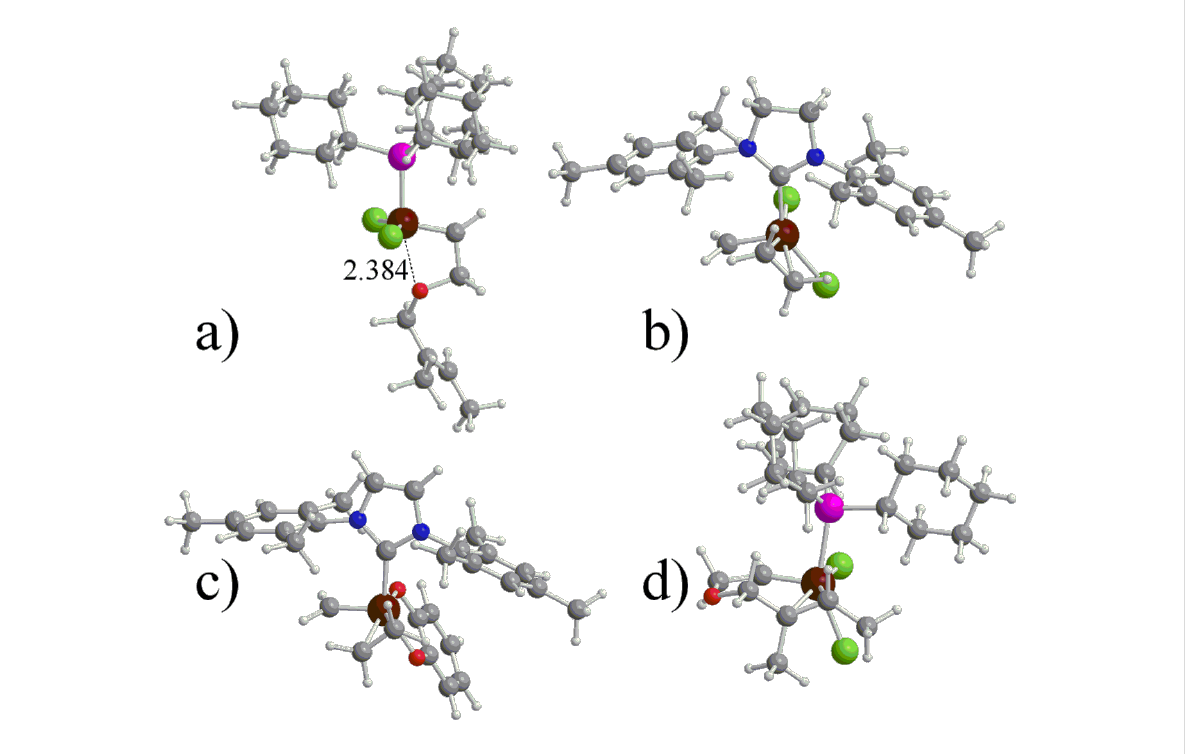
Figure 3: Naked 14e species for system 14 with the O atom of the substrate coordinated to the Ru center (distance in Å), part a; and representative coordination geometries for systems 7 , 11 and 14 with a cis coordinated C 2 H 4 molecule, parts b–d.